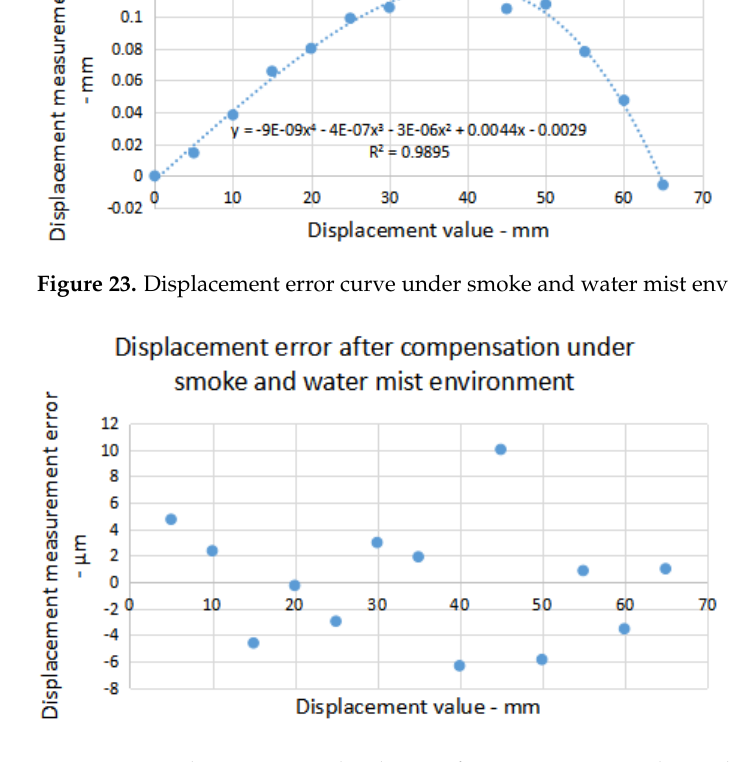
Figure 24. Displacement error distribution after compensation under smoke and water mist envi- ronment.